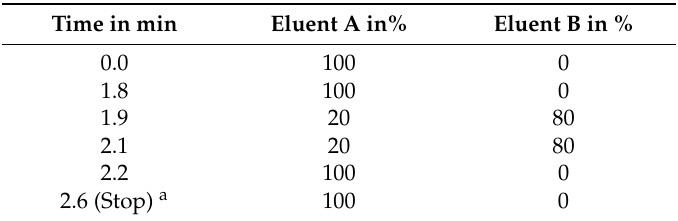
Elution program: see Table A4 for an elution with a flow rate of 1 ml/min or Table A5 for elution with a flow rate of 2 mL/min. Table A4. Elution program for 1 mL/min.